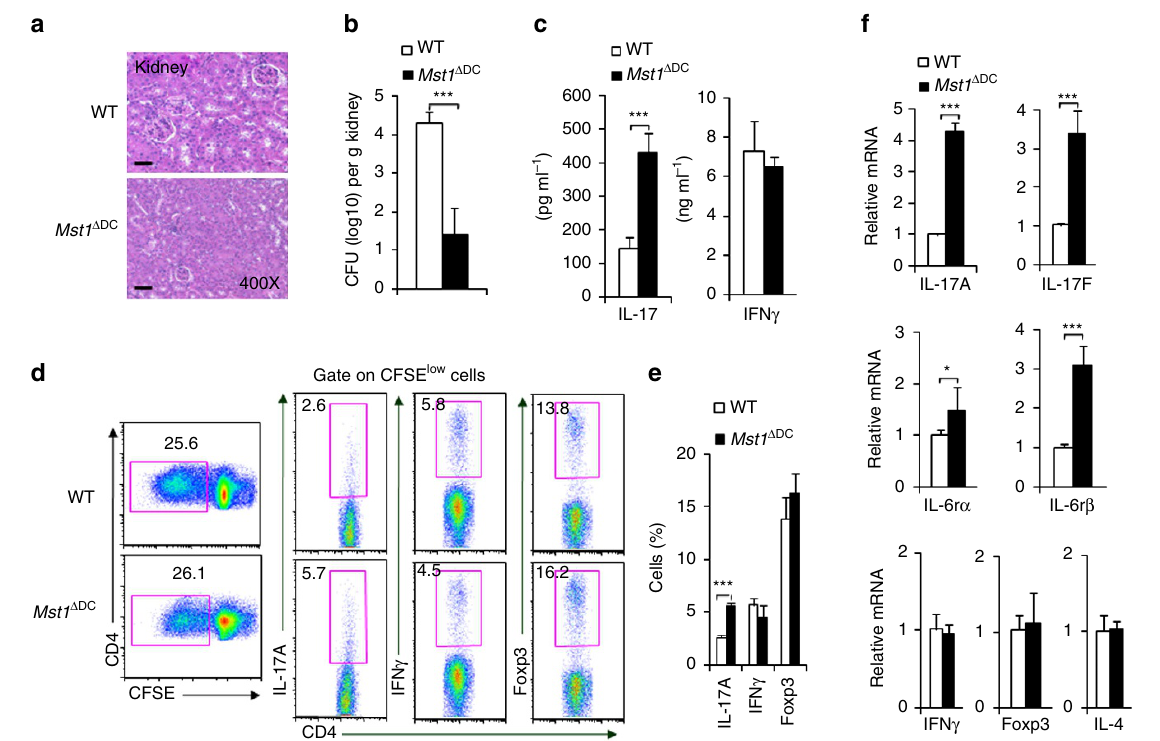
Figure 3 | DC MST1 inhibits Th17 differentiation in anti-fungi infection. Mice were infected with 10 5 C. albicans SC5314 by i.v. injection. After 9 days, kidneys were collected and a photo of the H&E staining of pathological kidney injuries is shown (Scale bars, 100 m m) ( a ) and the fungal burden in the kidneys expressed as CFU per g ( b ). ( c ) Serum cytokine level of IL-17 and IFN g in infected mice. ( d , e ) CD4 þ Tcells isolated from the spleen of the WTor Mst1 D DC mice were labelled with CFSE and stimulated with heat-killed C. albicans for 3 days. Intracellular staining of IL-17 and IFN g in CFSE low cells was determined with FCM. A typical figure is shown ( d ) and the data summarized ( e ). ( f ) CD4 þ T cells isolated from the spleen of infected WT or Mst1 D DC mice, and ex vivo stimulation was performed with anti-CD3 (1 m gml (cid:2) 1 ) for 24h, then mRNA expression of the indicated gene was analysed using qPCR (Levels in the WT groups were set to 1). Data are representative of three to four independent experiments (mean ± s.d.; n ¼ 4–8). * P o 0.05 and *** P o 0.001, compared with the indicated groups. P -values were determined using Student’s t